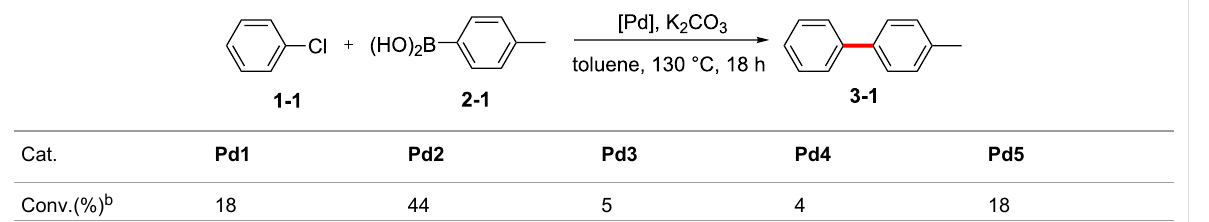
Table 1: Pd-catalyzed coupling of chlorobenzene and 4-tolylboronic acid using Pd1 – Pd5 as the catalyst. a